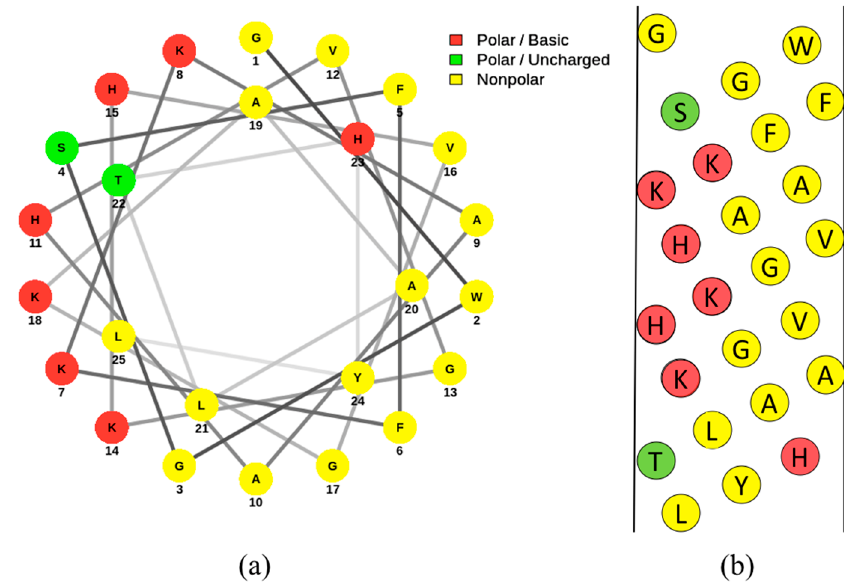
Figure 2. Helical wheel ( a ) and net diagrams ( b ) of pleurocidin [4]. Amino acids are indicated by their single-letter abbreviations and are categorized according to the following colors: red (polar basic), green (polar uncharged), and yellow (nonpolar). Both the wheel and net diagrams demonstrate the division of hydrophobic and hydrophilic components of the peptide. A slightly acidic pH is assumed, as the histidine residues are labelled as polar. The helical wheel diagram was generated using the online program NetWheels [35] and the net diagram was made using Microsoft PowerPoint.